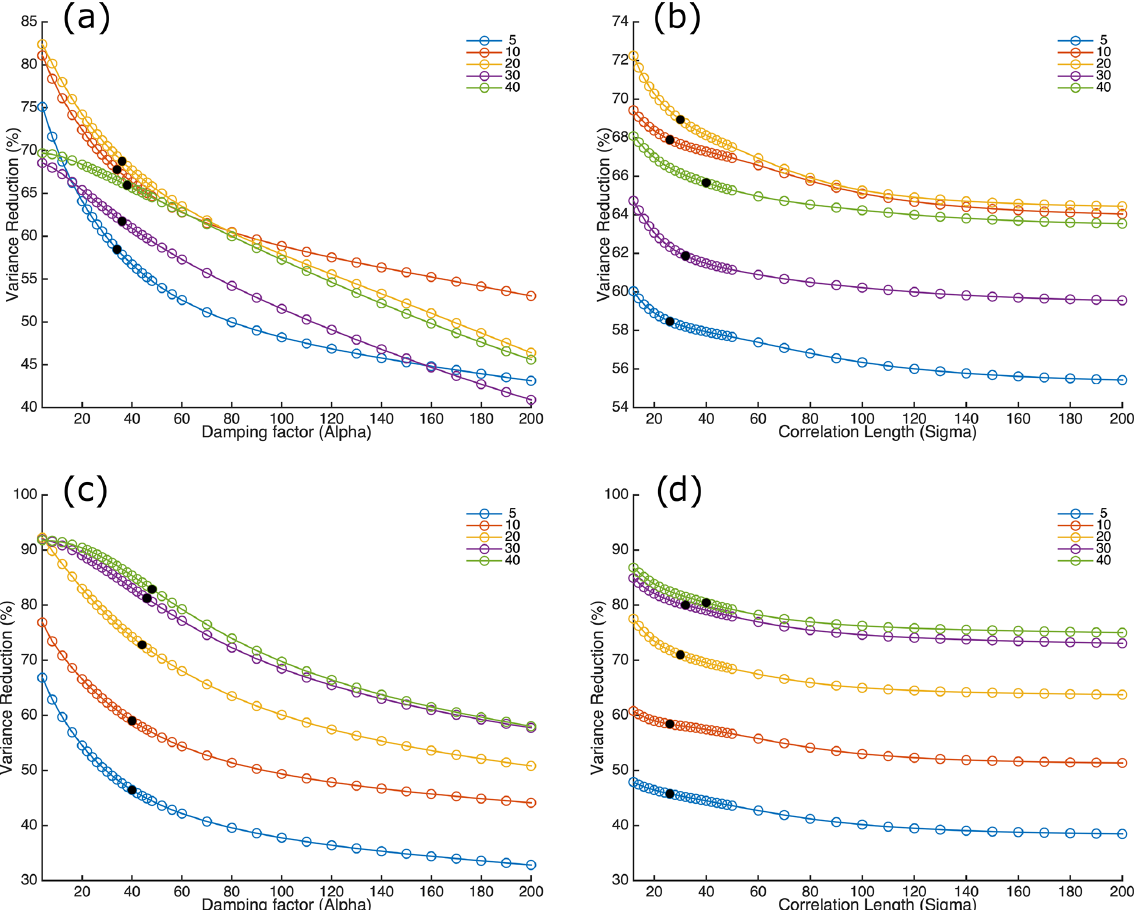
Figure 5. Variance reduction as a function of the inversion parameters. (a) L-curve analysis for damping factor ( α ) for Rayleigh waves at periods of 5, 10, 20, 30, and 40s. (b) Correlation length ( σ ) for Rayleigh waves in the same period range. (c, d) Variance reduction vs. damping factor and correlation length, respectively, for Love waves in the same period range. The selected parameters are shown by black